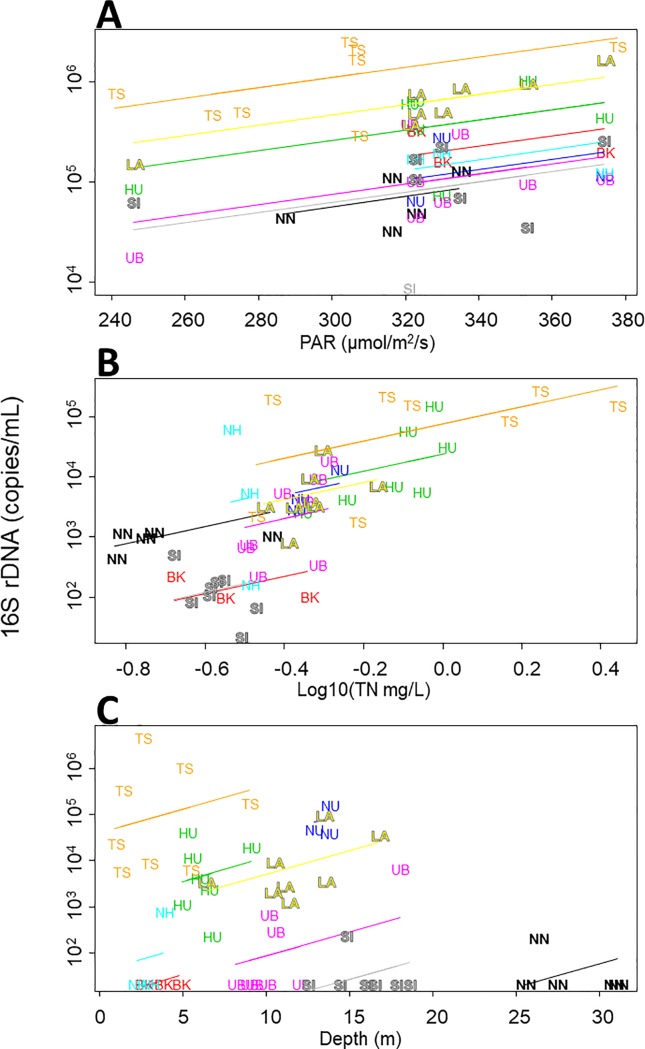
Regression models for the three algal taxa.16S rDNA densities of (A) Synechococcus spp., (B) Microcystis aeruginosa, and (C) Dolichospermum spp. plotted against a respective significant predictor, with separate regression lines for different water bodies, constituting another significant predictor, water. PAR, photosynthetically active radiation; TN, total nitrogen.